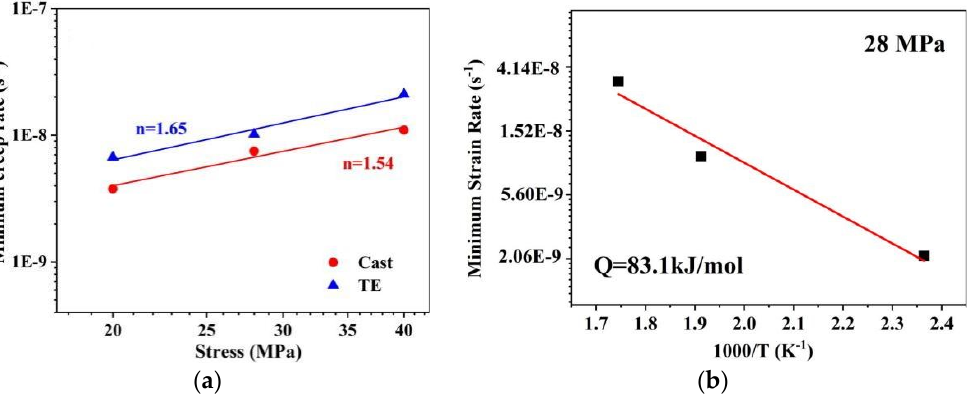
Figure 11. Al-Si-Cu-Ni-Mg alloy ( a ) creep stress exponent and ( b ) creep activation energy (TE represents thermal exposure at 250 °C for 200 h).